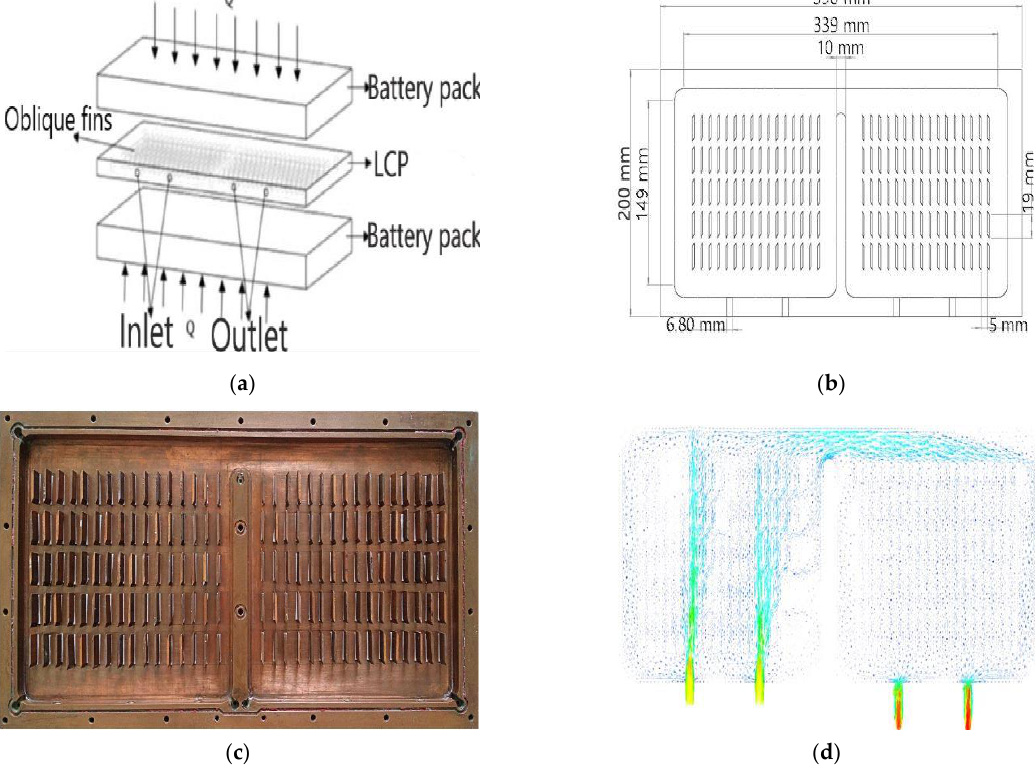
Figure 1. ( a ) Battery’s liquid cold plate system. ( b ) Liquid cold plate (LCP) and oblique fin dimension. ( c ) LCP with oblique fin arrangement. ( d ) The direction of the fluid flow.